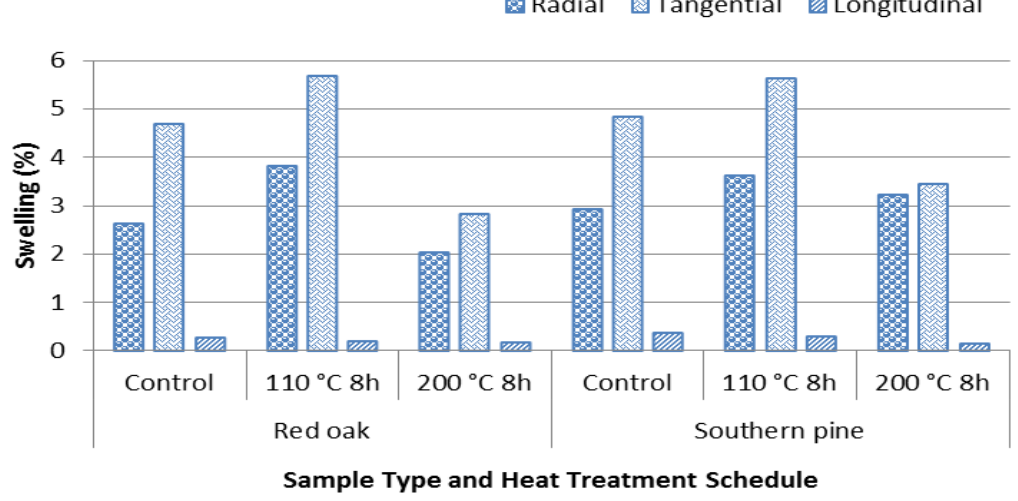
Figure 3. Swelling values of control and heat-treated